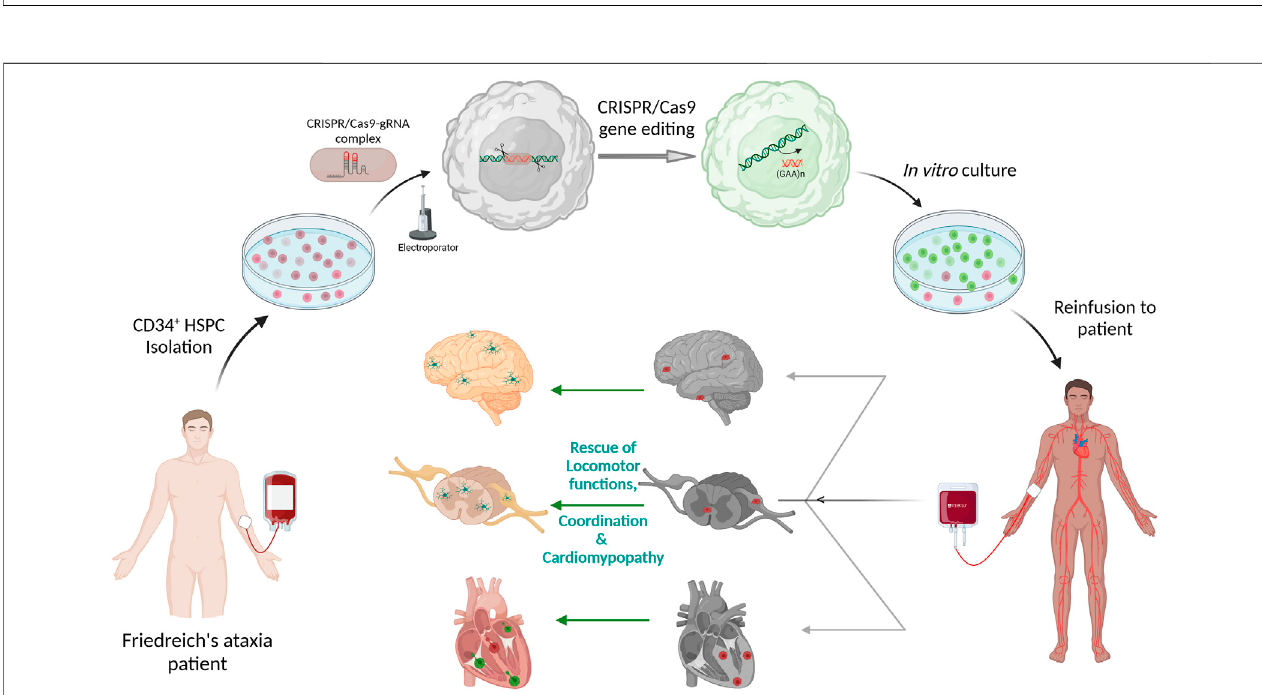
FIGURE 2 | Schematic representation of Autologous transplantation of CRISPR/Cas9 gene-edited CD34 + Hematopoietic Stem and Progenitor Cells (HSPCs) for Friedreich ’ s ataxia. CD34 + HSPCs isolated from peripheral blood of Friedreich ’ s ataxia patient will be electroporated with pre-complexed CRISPR/Cas9-guideRNA ribonucleoproteincomplexforexcisionofthe(GAA)nrepeatsequencesinintron 1of FXN .Thesegene-editedHSPCs willbeput back incultureand thenbereinfused to the same patient. The gene-corrected HSPCs are expected to engraft into the disease tissues such as the heart, brain, spinal cord and dorsal root ganglion to deliver frataxin to the neurons and myocytes. The schematic was created with BioRender.com.